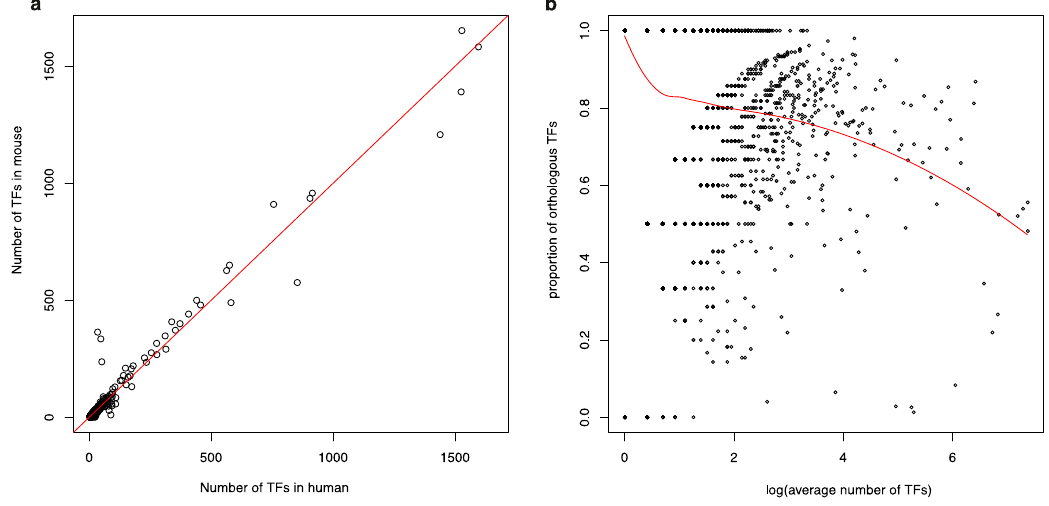
Figure 4. Shared and specific transcription factors (TFs) that regulate gene ontology (GO) terms in humans and mice. ( a ) Comparison of the number of TFs regulating GO terms in humans and mice. ( b ) Proportion of orthologous TFs relative to the average number of TFs. The red line in ( a ) represents the average number of TFs regulating GO terms in humans and mice. The smooth red curve in ( b ) represents the predicted proportion of orthologous TFs regulating GO terms.